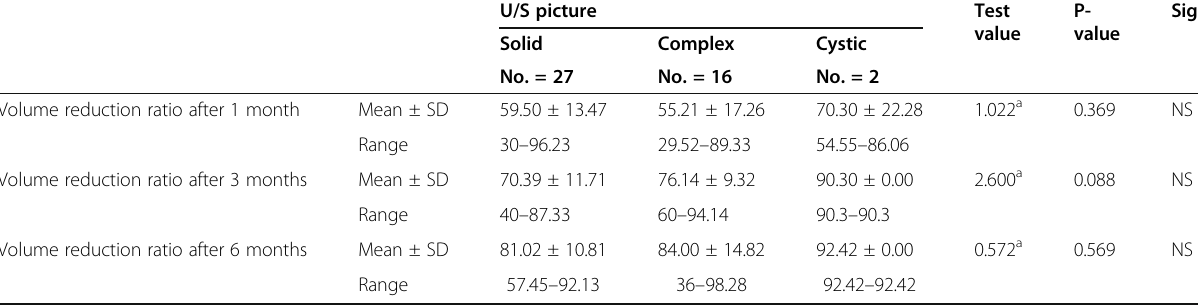
Table 5 The relation between the composition the thyroid nodule and the volume reduction ratio